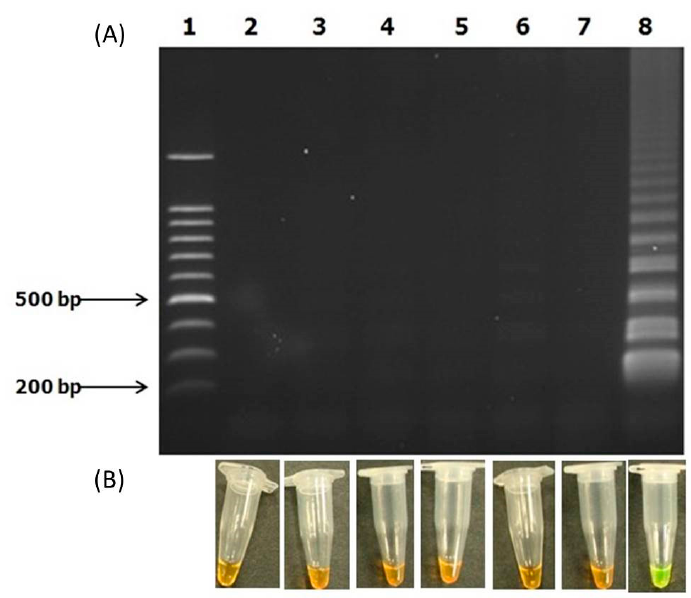
Figure 4. Specificity test for LAMP-SYBR green indicating the presence of amplicons for only V. harveyi . ( A ) LAMP amplicons visualized with gel electrophoresis in a 1.5% agarose gel and stained with ethidium bromide. ( B ) The corresponding LAMP assay visualized with SYBR green. Lane 1: 100 bp DNA ladder, Lanes 2–3: negative controls (distilled water), Lane 4: Aeromonas salmonicides subsp. salmonicida ATCC strain 33658, Lane 5: V. aguillarium ATCC 19264, Lane 6: V. alginolyticus ATCC 17749, Lane 7: V. parahaemolyticus ATCC 17802, Lane 8: V. harveyi strain VHJR 7.